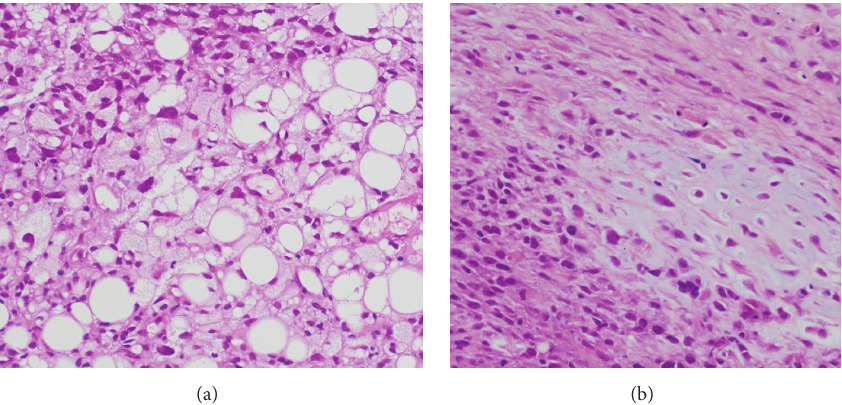
Figure 2: (a) Pathology (hematoxylin and eosin staining, 400x) showing a dense growth of atypical cells indicating differentiation of fat cells; the atypical cells had a clear nucleolus with weakly acidophilic foamy cytoplasm. (b) Pathology (hematoxylin and eosin staining, 400x) showing differentiation of cartilage cells buried among clear cartilage tissues with the dense growth of fusiform immature undifferentiated mesenchymal cells with a high nucleocytoplasmic ratio.